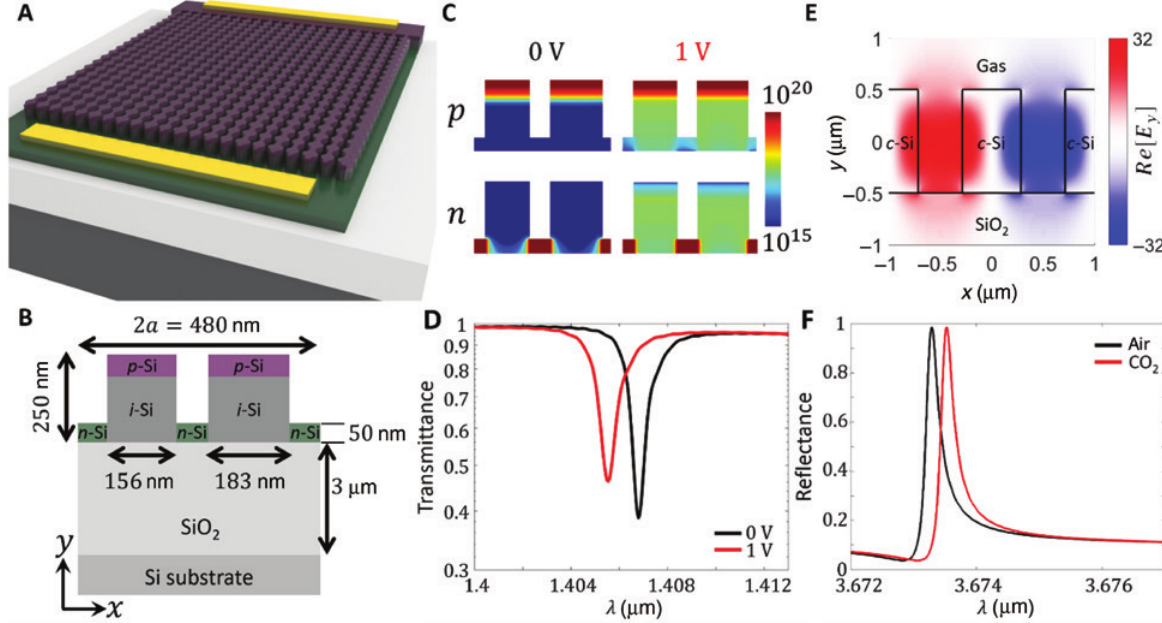
Figure 5: Applications of DHCGs. (A) Schematic of an optical modulator based on a corrugated w-DHCG incorporating p -type doping (purple) at the top of the fingers and n -type doping (green) at the bottom of the etched trenches, leaving intrinsically doped (gray) centers of the fingers. Electrodes (gold) allow for forward biasing of the resulting p-i-n junction, injecting carriers into the intrinsic region. (B) Geometrical parameters of a period of the modulator portrayed in (A). (C) Solutions to the drift-diffusion equations on a finite element grid, showing hole ( p ) and electron ( n ) concentrations (cm −3 ) on a log scale for applied voltages of 0 V and 1 V. (D) Transmission spectra near the B with Q ≅ 1,500 for applied voltages of 0 V and 1 V. The spectra are calculated using FDTD and a free-carrier model for the complex refractive indices based on the distributions of holes and electrons in (C). This simulation fully takes into account material losses as well as finite-size effects in the x -direction. The corrugation of the fingers in the z -direction is expected to localize the mode along the grating fingers. (E) A mode of a silicon DHCG on oxide showing excellent field overlap with an external gas when TM ( x -polarized) light is incident from above. (F) Reflectance peaks ( Q ≅ 3500) near the mode in (E) with surrounding refractive indices of 1.0002 (air) and 1.001 (CO